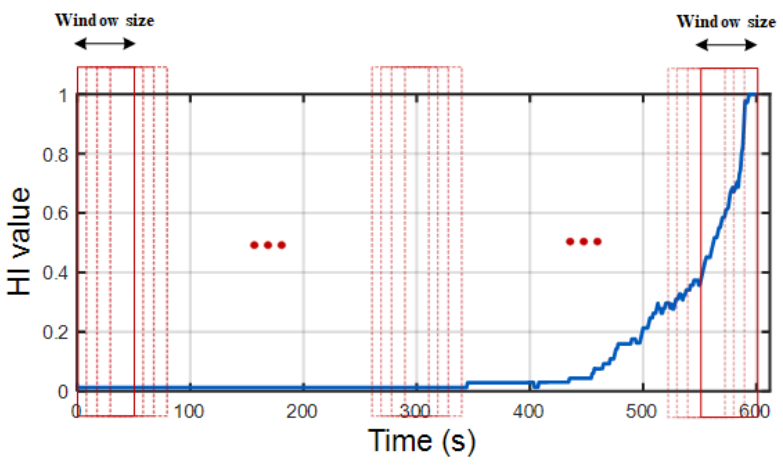
Figure 13. Time series construction from training degradation data.